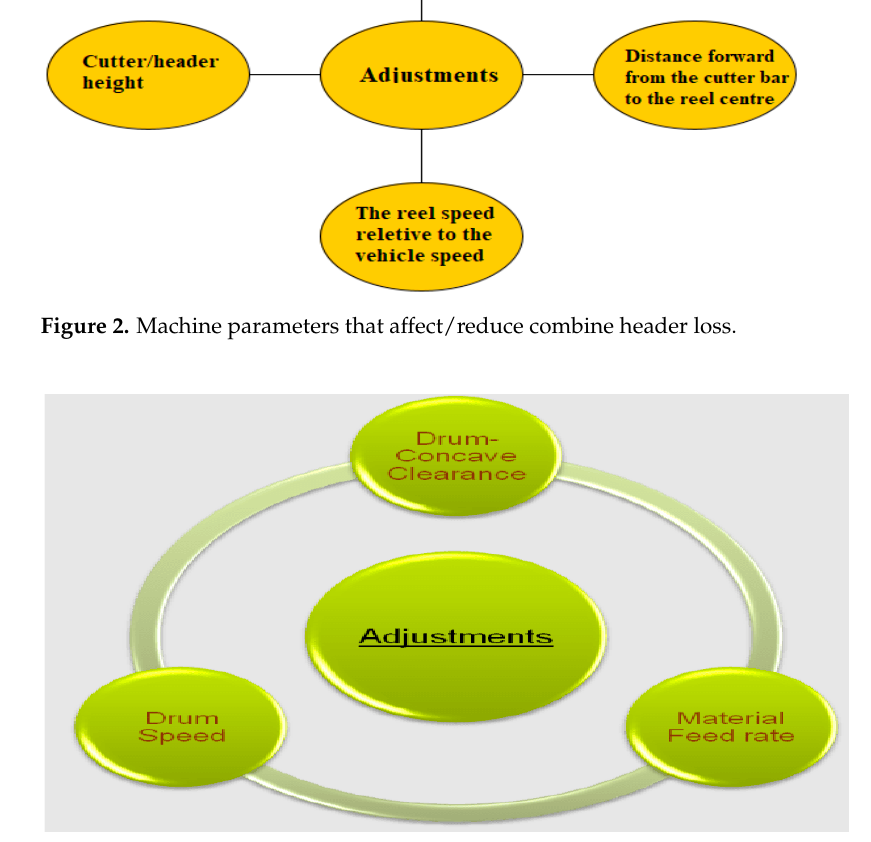
Figure 2. Machine parameters that affect/reduce combine header loss.